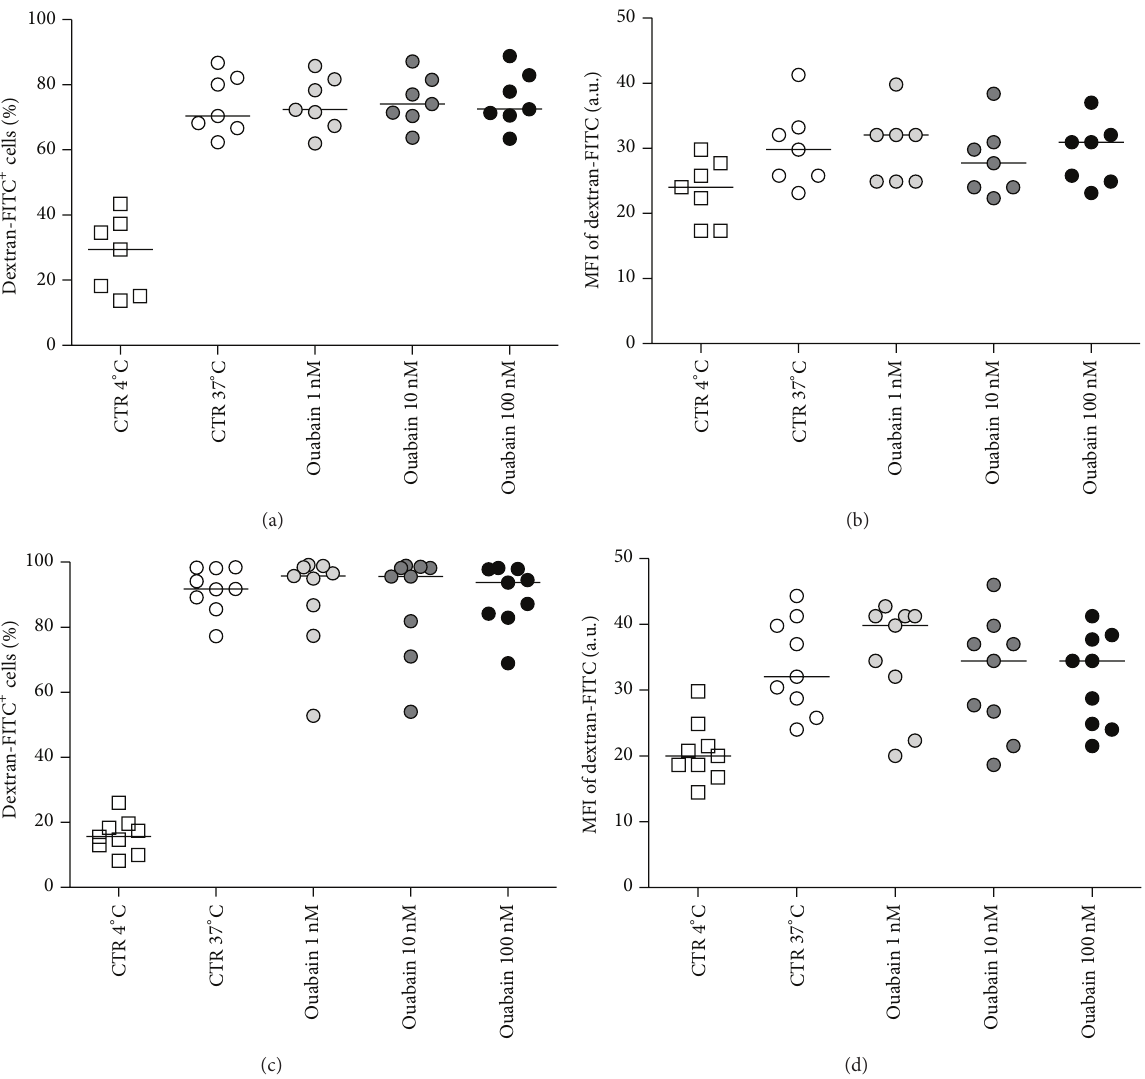
Zymosan injection in Swiss mice induces massive poly- morphonuclear leukocytes (PMN) influx with maximal cell accumulation at the 4th hour of peritonitis [27, 28,